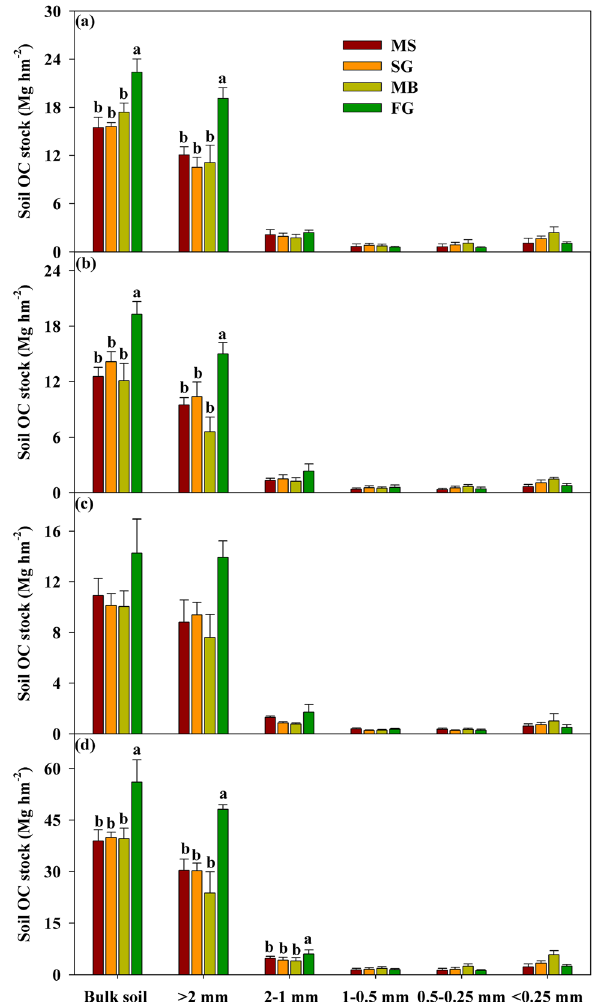
Figure 3. OC stocks of bulk soil and aggregate fractions under four land use types at ( a ) 0–10 cm, ( b ) 10–20 cm, ( c ) 20–30 cm, and ( d ) 0–30 cm, respectively. Values presented as means with standard error. Different letters indicate significant difference at p < 0.05 among four cropland use types. MS: maize-soybean; SG: sugarcane; MB: mulberry; FG: forage